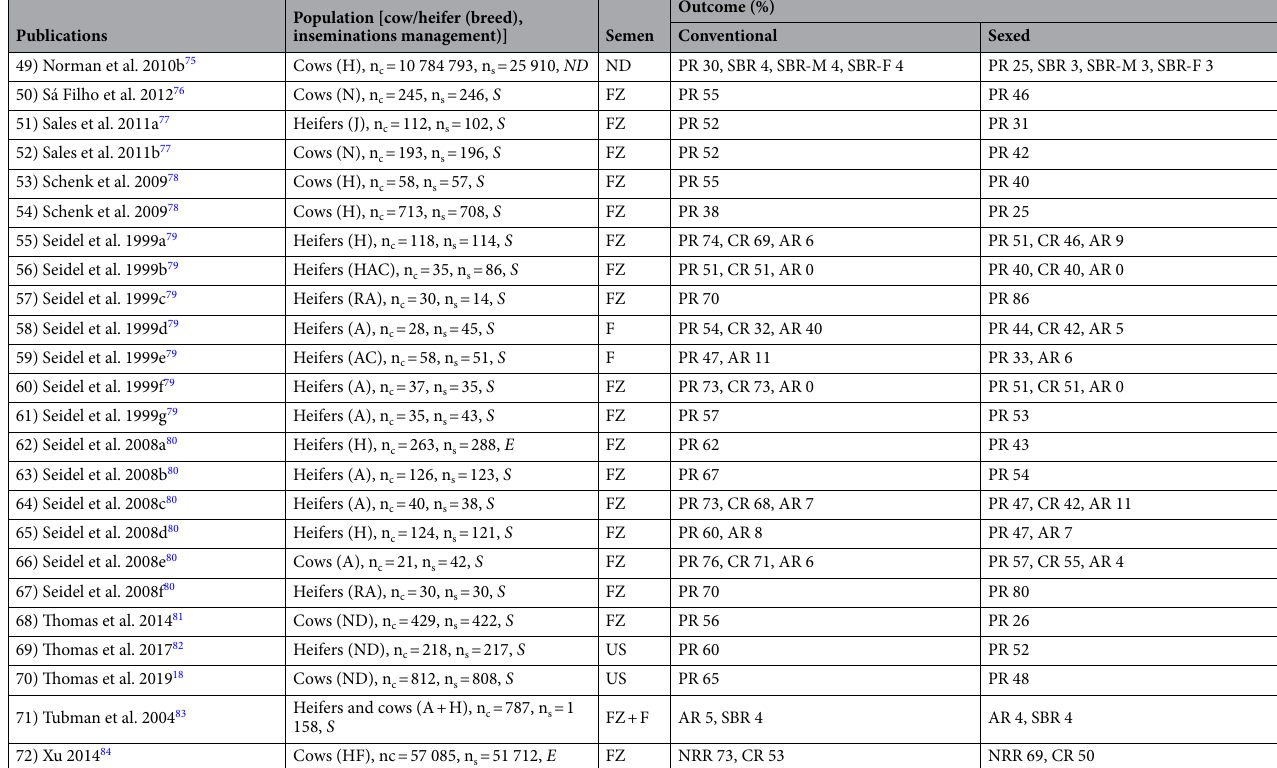
Table 1. Descriptive data of trials included in meta-analysis. Semen: FZ: Frozen. F Fresh, US UltraSexed (frozen). ND: not determined.n c : number of inseminations with conventional sperm, n s : number of inseminations with sex-sorted sperm, Breeds: (A) Angus. (AC) Angus crossbreed. (BPL) Black Pied Lowland.